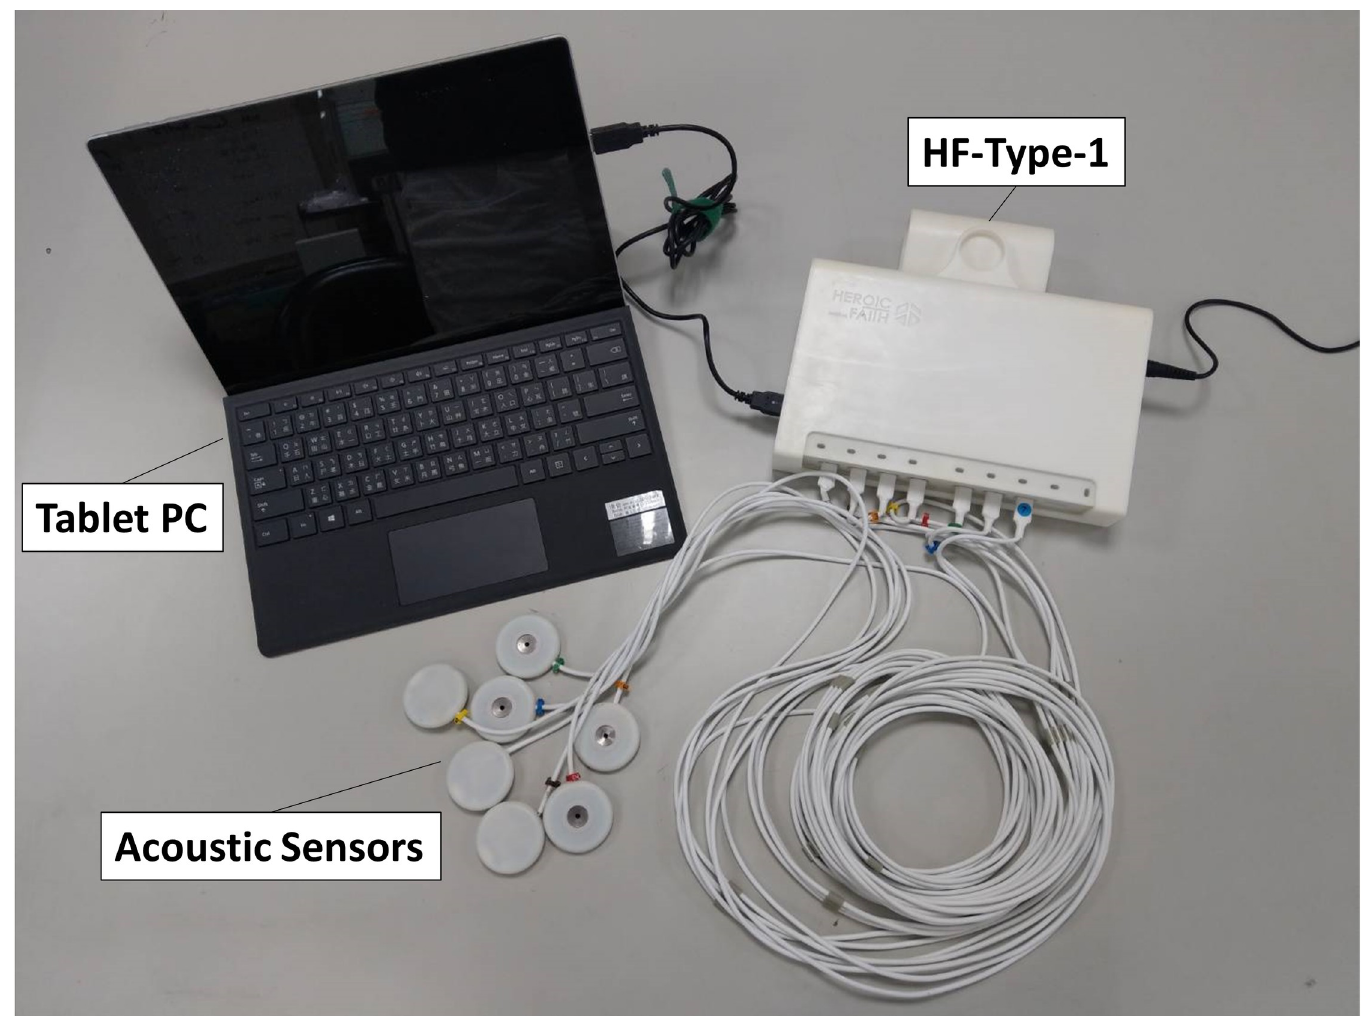
Fig 1. Customized multichannel acoustic recording device (HF-Type-1) connected to a